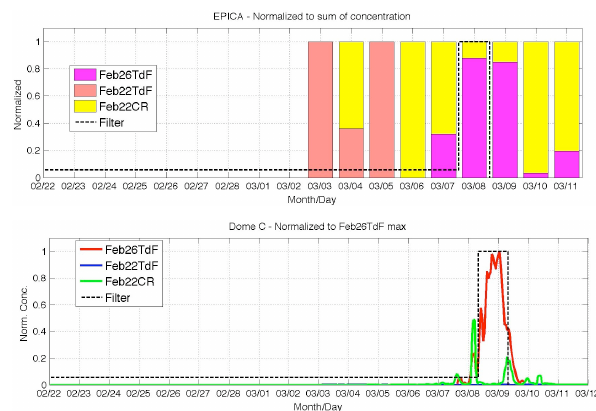
Fig. 4. Time of HYSPLIT surface concentrations at Concordia Figure 4: Time of HYSPLIT surface concentrations at Concordia (123E,75S) for 3 (123E, 75S) for 3 dust events described in text and the dashed black dust events described in text and the dashed black line is the nss-Ca filter line is the nss-Ca filter measurement at Dome C. Top: the contribu- measurement at Dome C. Top: the contribution of each run to the total concentration for that day and Bottom: Surface concentrations normalized to the maximum of tion of each run to the total concentration for that day and Bottom: Feb26TdF. Top figure illustrates the relative contribution of each dust event. Surface concentrations normalized to the maximum of Bottom figure shows that most of the dust arriving to Dome C on March 08 originated in Tierra del Fuego on Feb26.